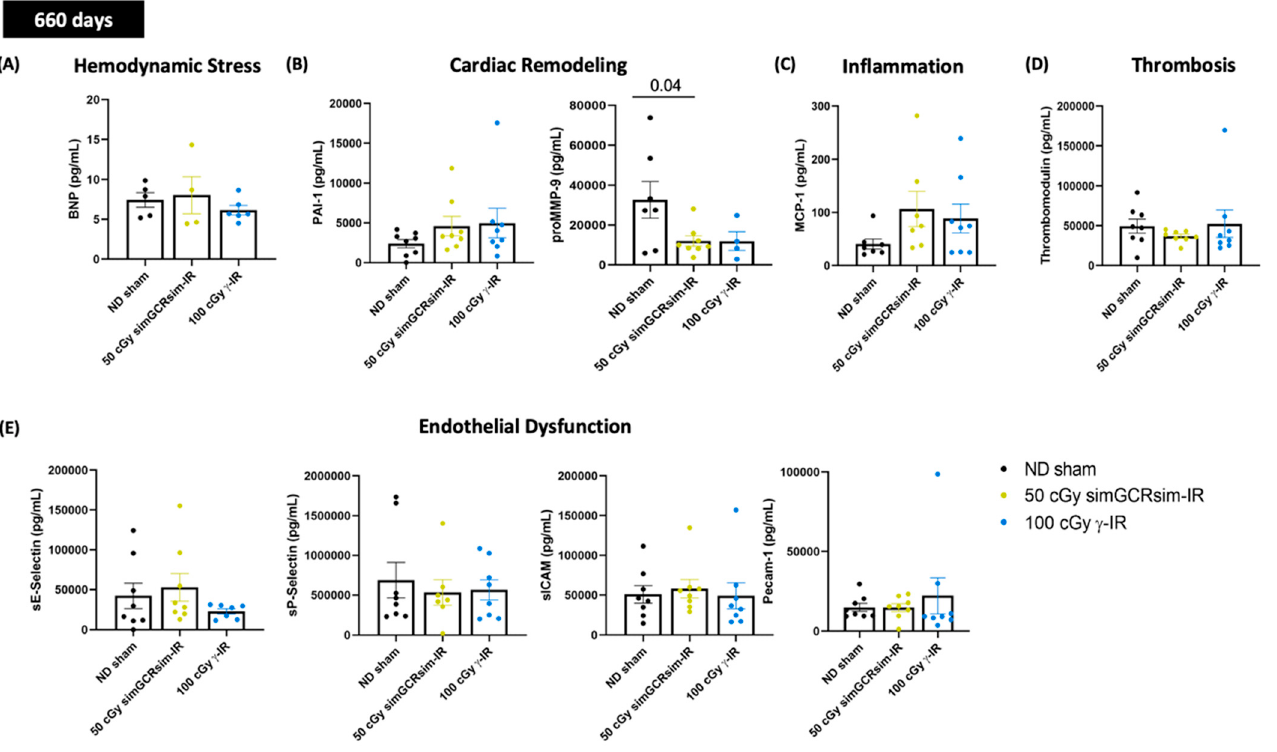
Figure 6. Select cardiac serum markers assessed 660 days after gamma and simGCRsim irradiation. Peripheral blood serum was processed using standard ELISA to assess serum levels of ( A ) brain natriuretic peptide (BNP). Remaining samples were used for Multiplex assay to assess markers of ( B ) cardiac remodeling: plasminogen activator inhibitor-1 (PAI-1) and pro-matrix metalloprotease-9 (proMMP-9), ( C ) inflammation: Monocyte Chemoattractant Protein-1 (MCP-1), ( D ) Thrombosis: thrombomodulin, and ( E ) endothelial dysfunction: sE-Selectin, sP-Selectin, sICAM, and PECAM-1. All values are reported as pg/mL as mean ± SEM. n = 5 animals/treatment group. p -values were calculated using Kruskal-Wallis H test.